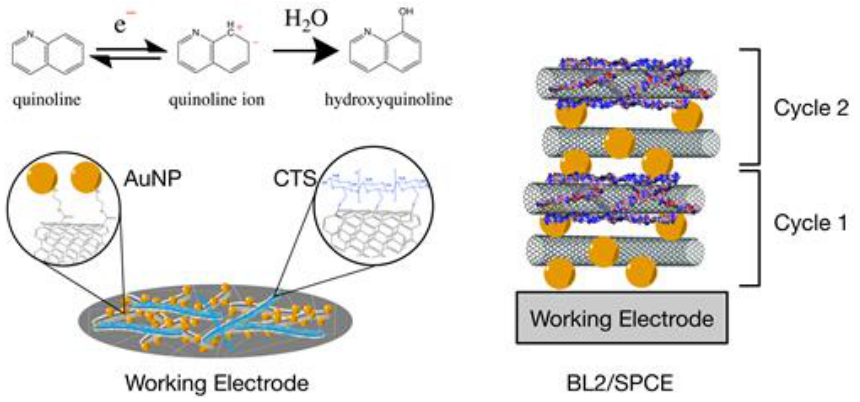
Figure 1. Schematic diagram of the modified electrode and the reaction of quinoline on the surface of the